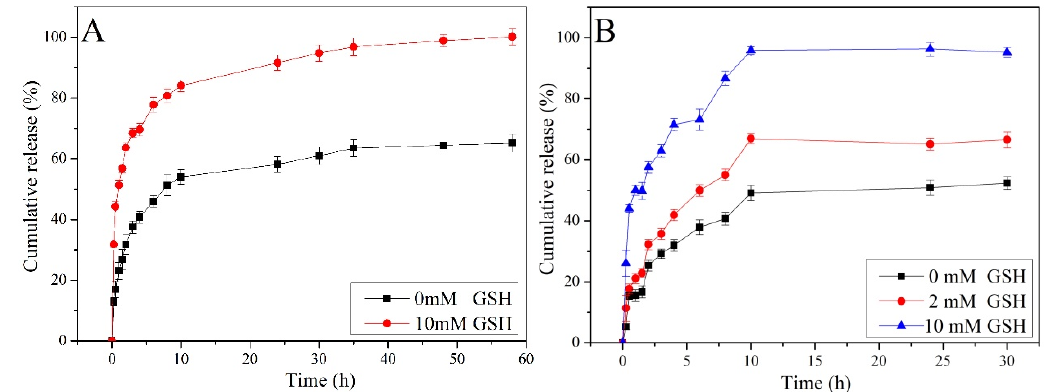
Figure 6. Release of DOX ( A ) and NAP ( B ) from nanocarriers at different concentrations of GSH (pH = 7.4, T = 25 °C).